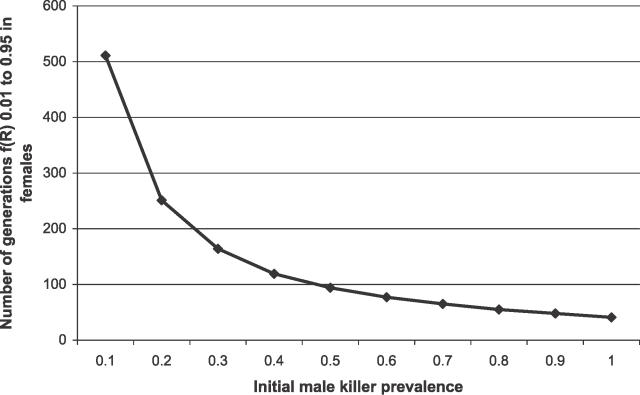
Time of Spread of the Male-Killing Suppressor with Varying Initial Male Killer PrevalenceTime (given as the number of host generations) taken to spread from 1% to 95% frequency for a zygotically acting, single locus dominant suppressor of male killing, with varying initial prevalence of male-killing wBol1 strain. Results are derived from simulation of gene frequency changes for varying initial prevalence of wBol1 (given in Protocol S1), with the assumption that wBol1 shows perfect vertical transmission and no direct benefit or cost to the female host, save death of male offspring. The simulation assumes the suppressor rescues males completely, is fully penetrant, and has no direct cost. Code for the recursions is available on request.